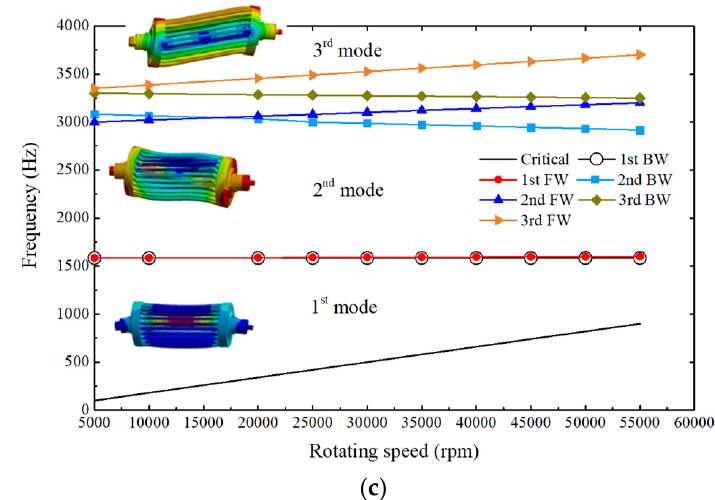
Figure 14. Campbell diagram considering the stiffening effect of the rotor cage. (a) 1st mode @ 1565.9 Hz, (b) 2nd mode @3563.8 Hz, the Campbell diagram of the rotor dynamic performance at the high stiffness bearing housing condition .